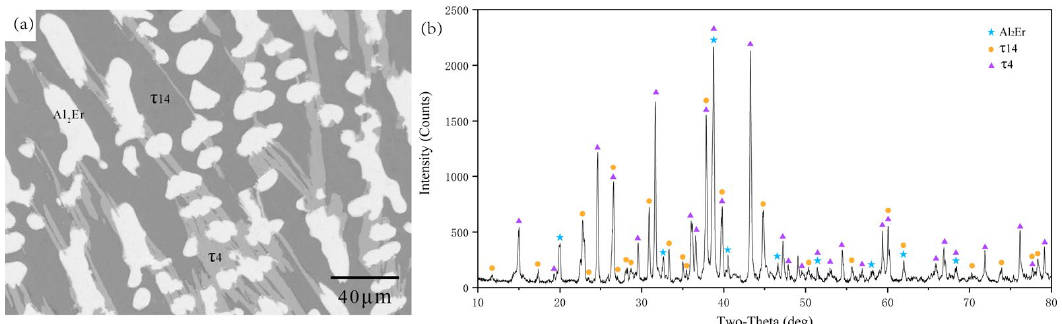
Figure 10. Sample B8’s ( a ) BSE image and ( b ) XRD pattern.